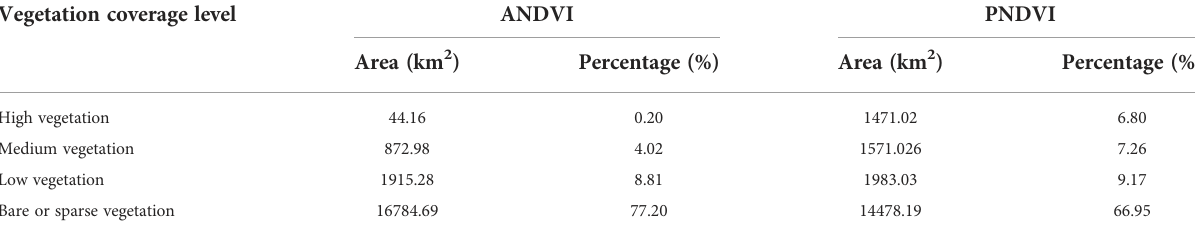
TABLE 3 The area and percentage of ANDVI and PNDVI with different vegetation coverage